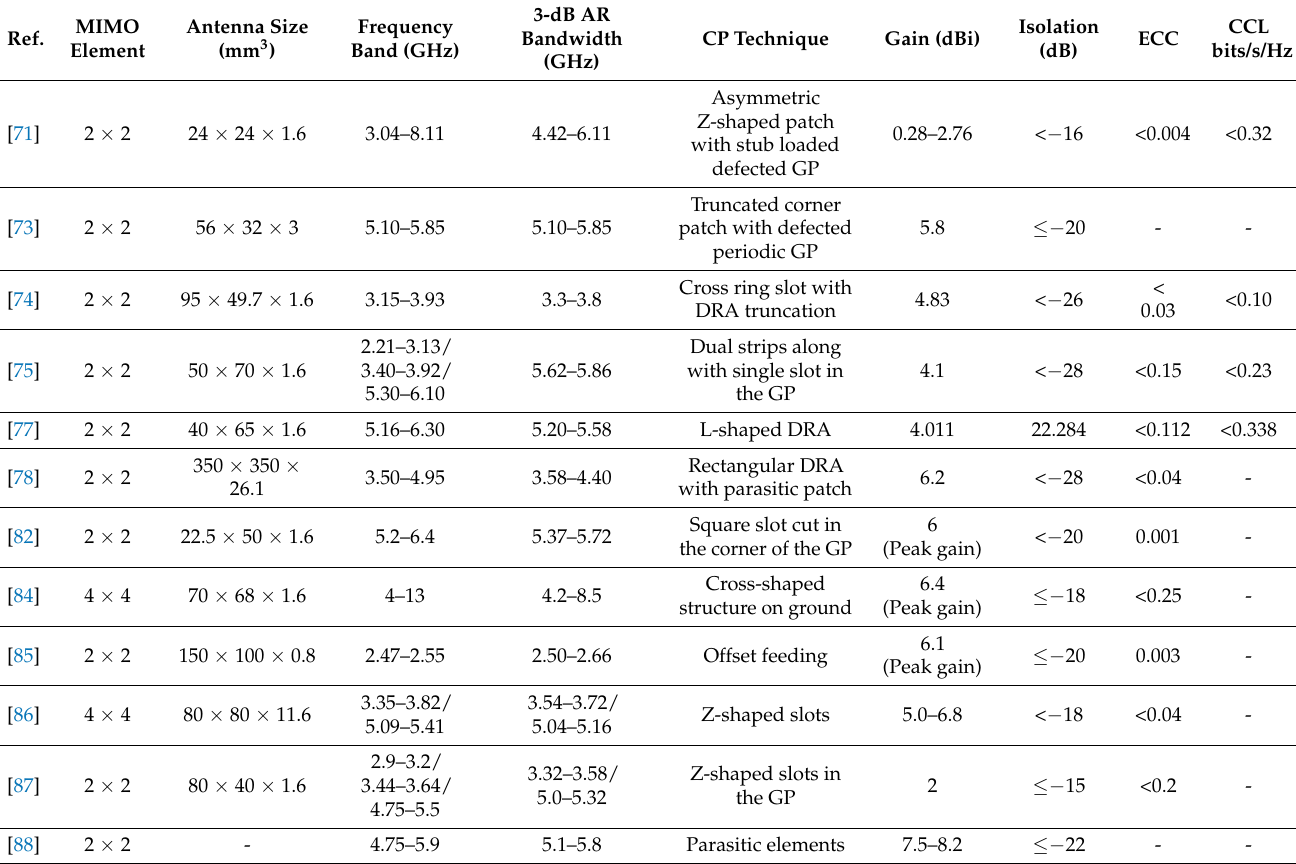
Table 3. Comparison of different circularly polarized MIMO